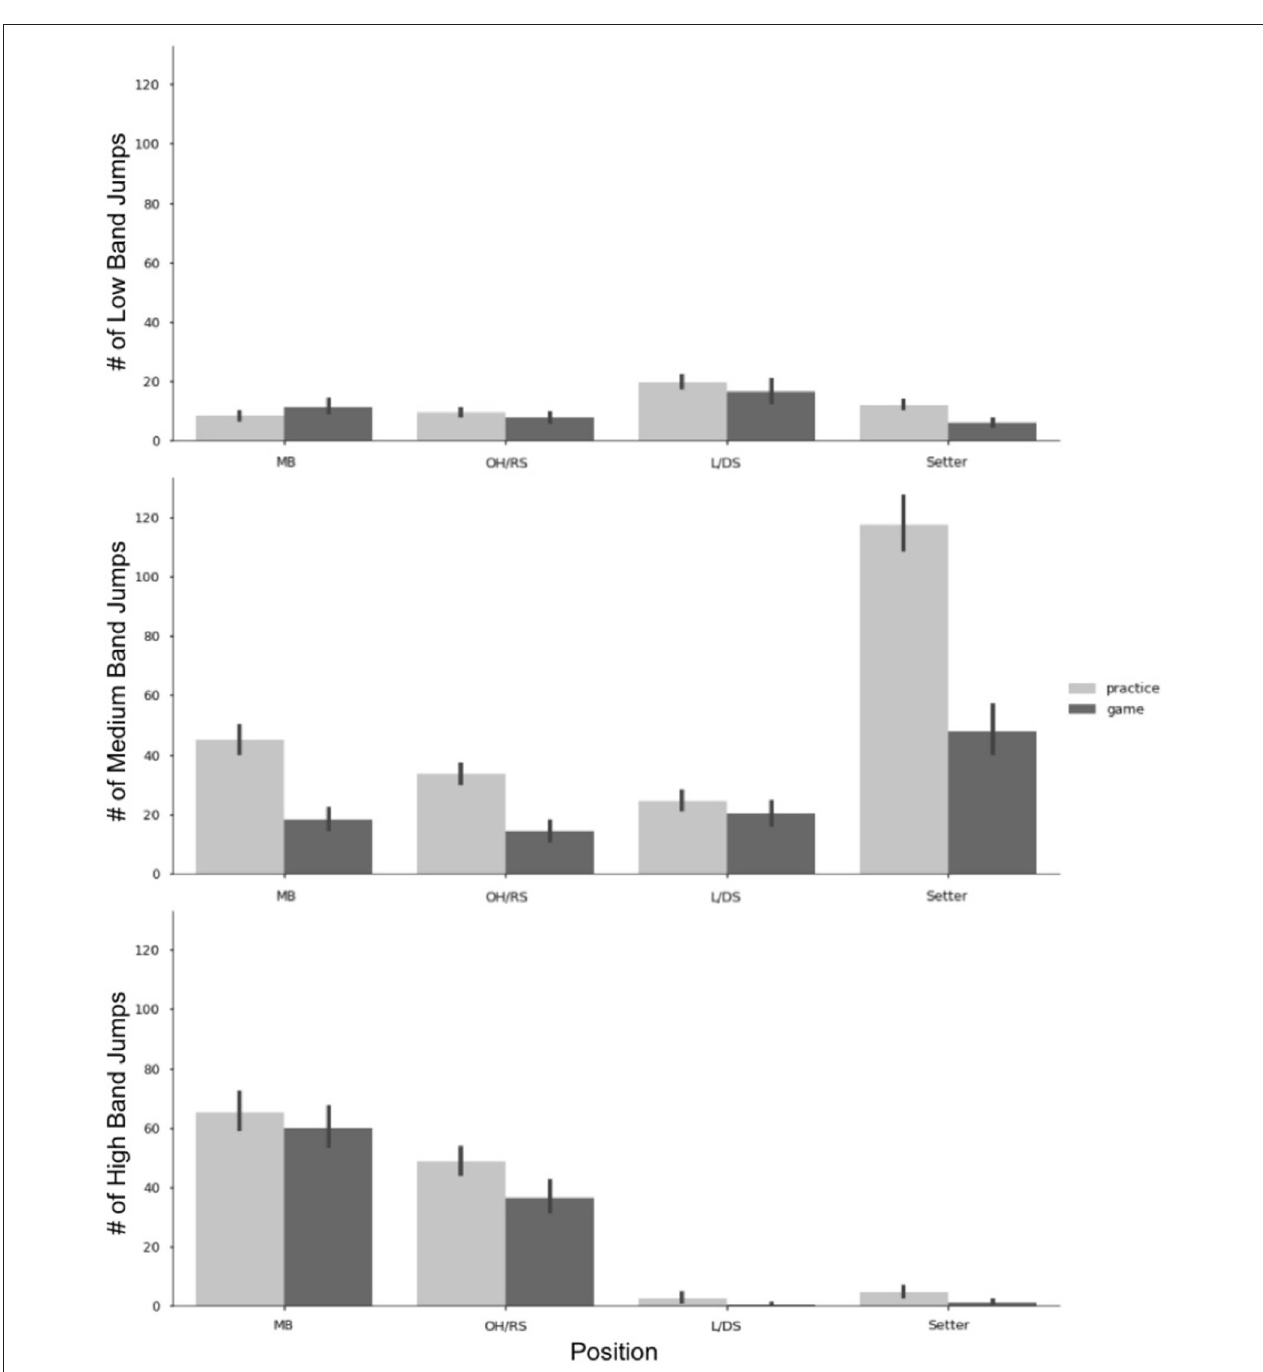
FIGURE 6 | Jump counts by band, position, and game or practice. Error Bars represent 95% CI. MB, middle blocker; OH/RS, outside hitter/right side hitter; L/DS, libero/defensive